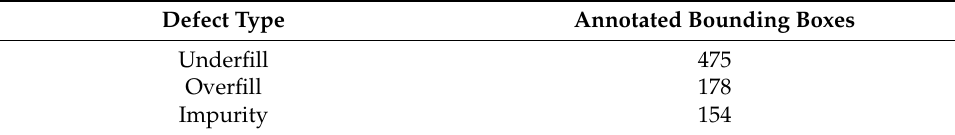
Table 1. Number of annotated objects from training set images.